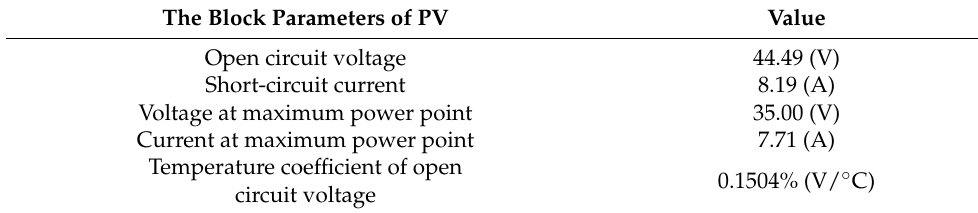
Table 2. The block parameters of the designed PV system.